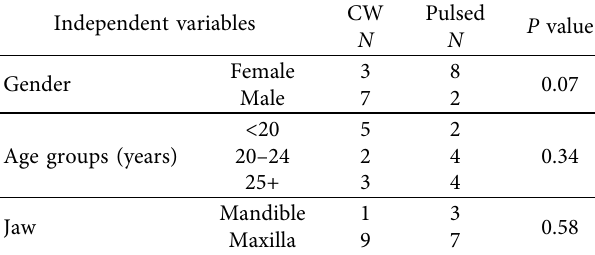
Table 1: Displays the demographic data of participants in both